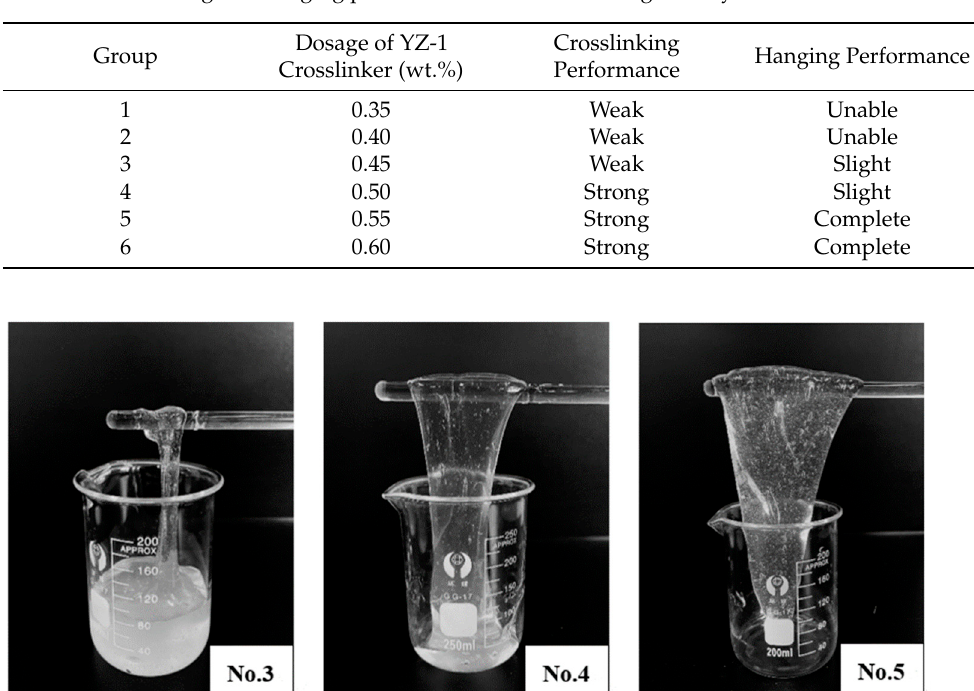
Table 5. Crosslinking and hanging performances of the fracturing fluid system.